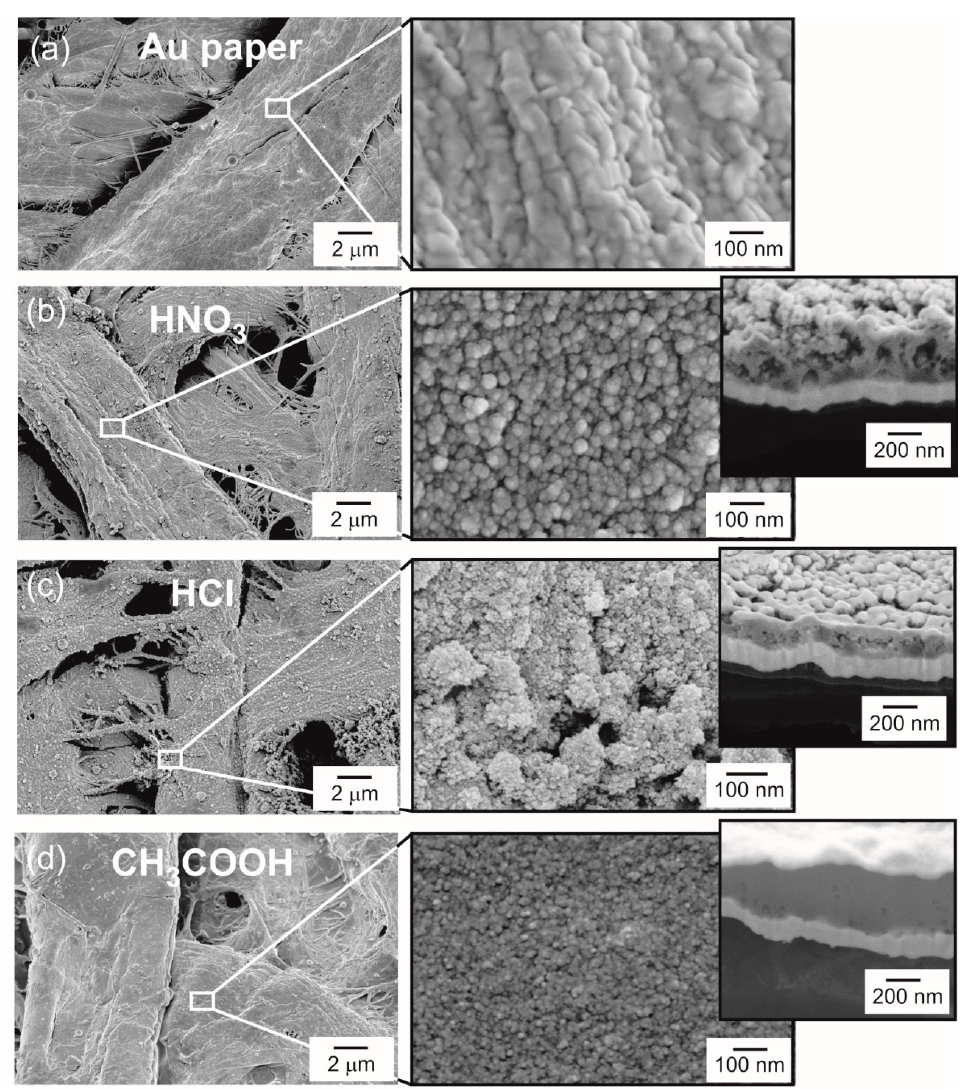
Figure 2. SEM images showing the Whatman paper with an Au film and the TiO 2 nanostructured films grown under microwave irradiation. ( a ) Whatman paper with a 140 nm Au film deposited by ebeam to act as contact. ( b ) Synthesis of the TiO 2 nanostructured films using nitric acid, ( c ) hydrochloric acid, and ( d ) acetic acid. The insets demonstrate the TiO 2 film thicknesses. An Au/Pd sacrificial layer has been deposited on the top of the TiO 2 films.